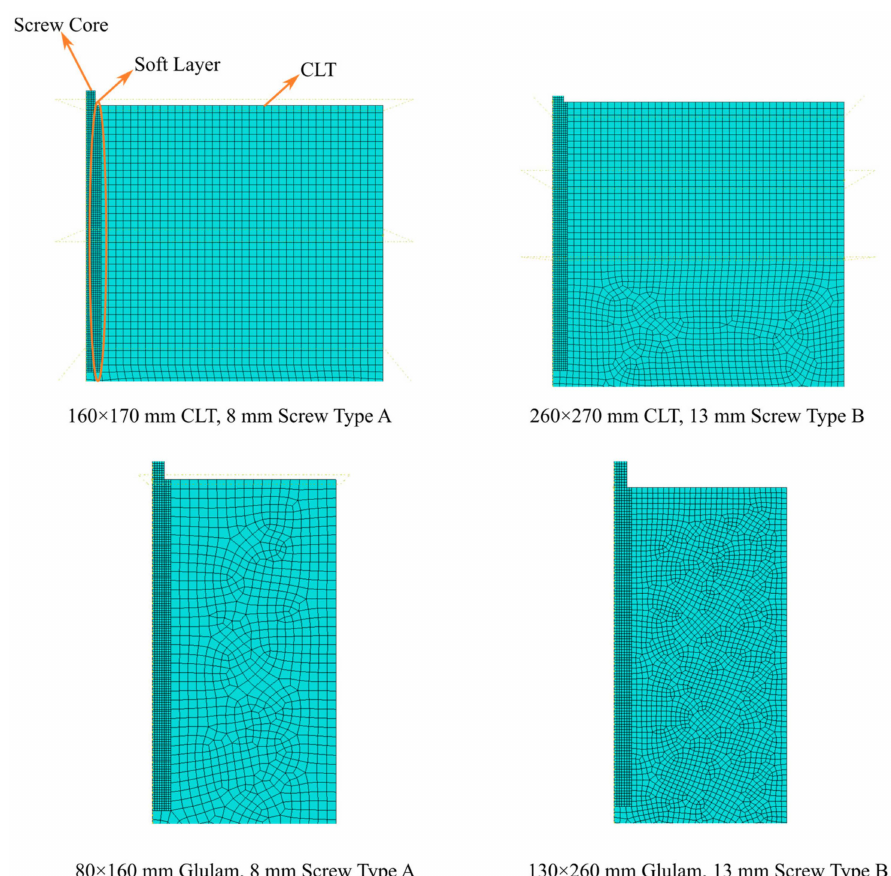
Figure 9. Mesh for the different